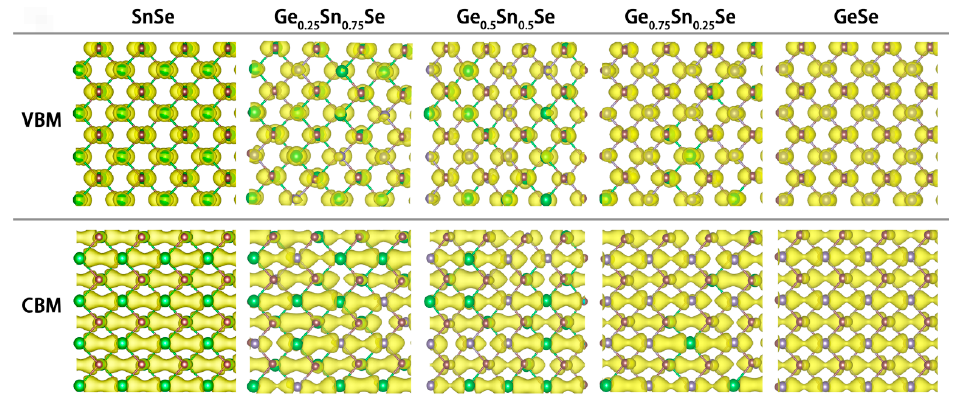
Figure 4. Partial Charge Densities at the VBM and CBM States for the Selected Alloys, where Green, Purple, and Grey Balls Represent Sn, Se and Ge Atoms, respectively.